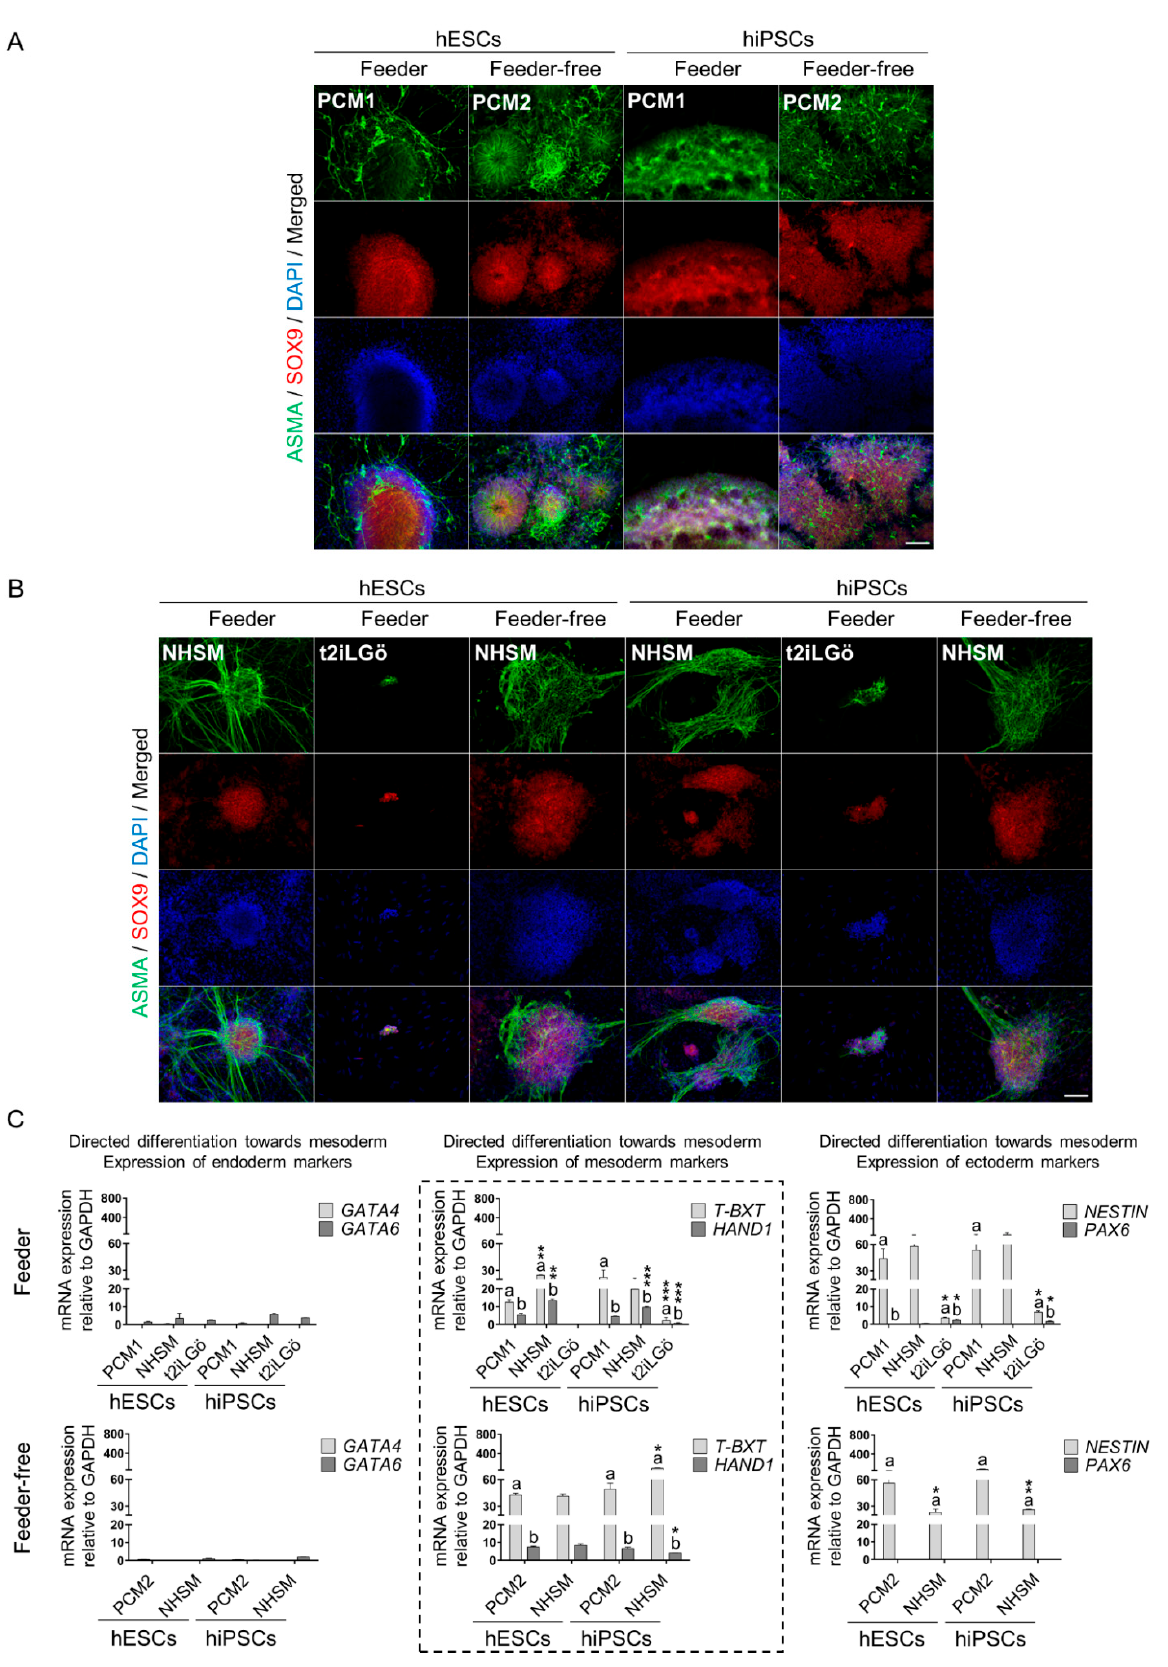
Figure 5. Mesoderm layer directed differentiation of primed and naive hPSCs (hESCs, hiPSCs). ( A , B ) Immunofluorescence analysis of mesoderm specific markers (ASMA and SOX9) on primed